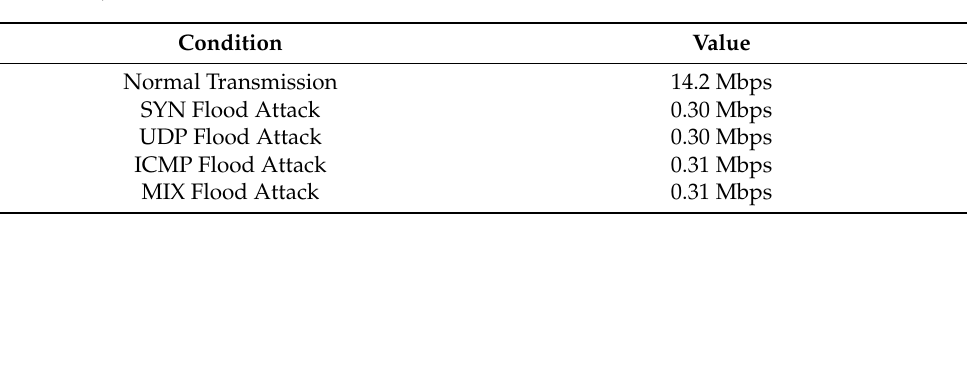
Table 4. Average speed under the normal transmission, SYN flood attack, UDP flood attack, ICMP flood attack, and MIX flood